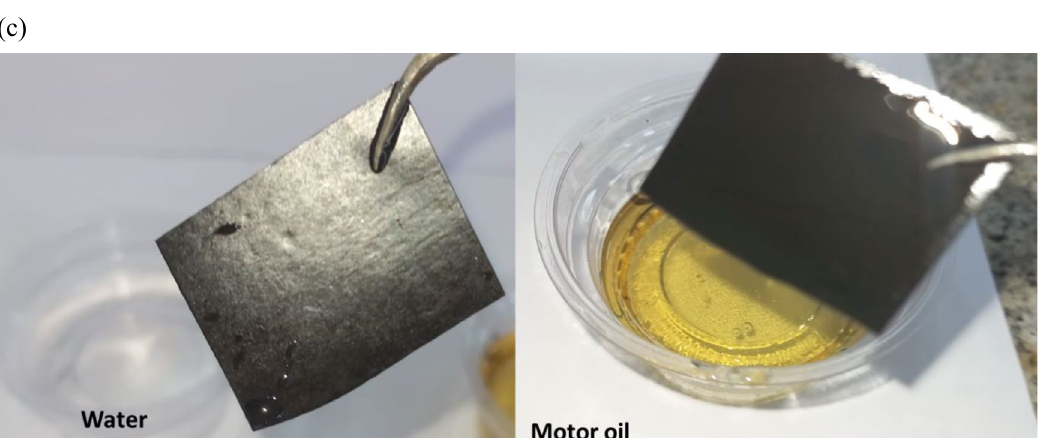
Figure 7. ( a ) adsorption capacity of motor oil and castor oil by aminated modified PVC in (PVC/LLDPE)ZnO depending on the nature of the aminating reagent, ( b ) the proposed intermolecular H-bonds formation between Castro oil and NH 2 groups in (PVC/LLDPE)ZnO-EDA samples and ( c ) the efficiency of motor oil removal by